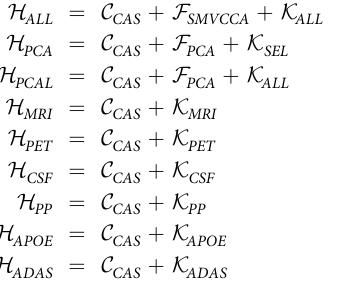
Experiment 3: Evaluation of Fused Representation on Binary Classification Tasks. We